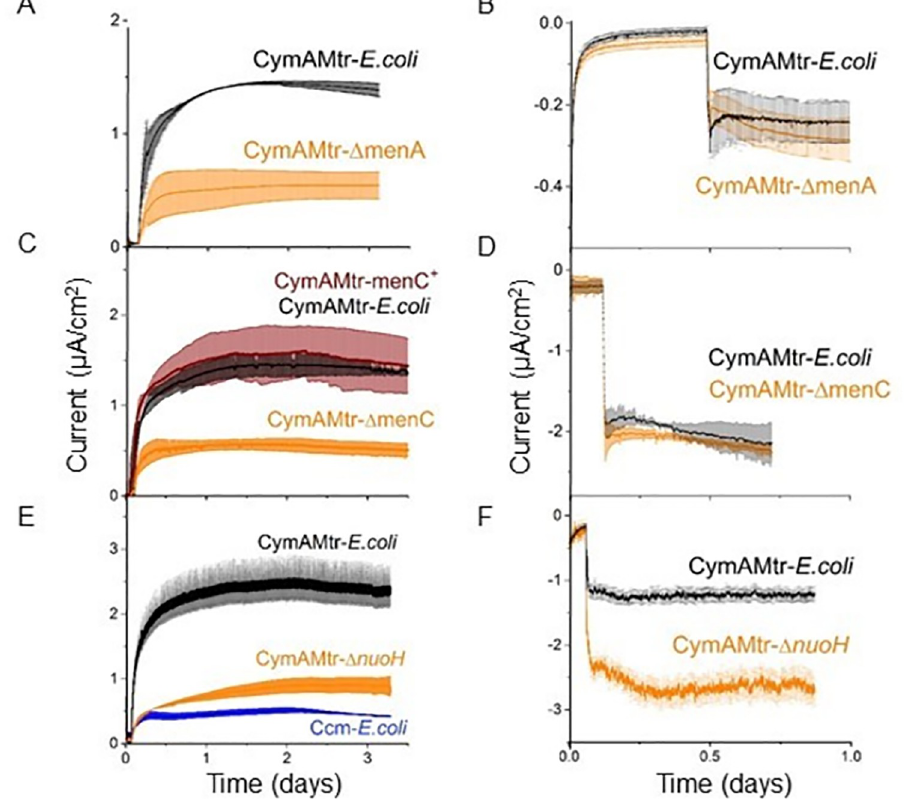
Fig 4. Mtr-expressing E . coli requires menaquinone and Complex I to generate current, but does not require them to consume current. (A,C,E) Current production under anodic conditions and (B,D,F) current consumption under cathodic conditions for the CymAMtr- E . coli in wt (black) and gene deletion (orange) backgrounds. (A,B) Current as a function of time for CymAMtr- E . coli in the (A,B) Δ menA background and (C,D) Δ menC background (orange). Complemented strain menC + is shown in red. (E) Current as a function of time for CymAMtr- E . coli in the Δ nuoH background. The anode was poised to +200 mV Ag/AgC and the cathode was poised to -560 mV Ag/AgCl for all experiments. Fumarate was added to 50 mM, and the error bars indicate the standard deviation in current from triplicate bioelectrochemical reactors.